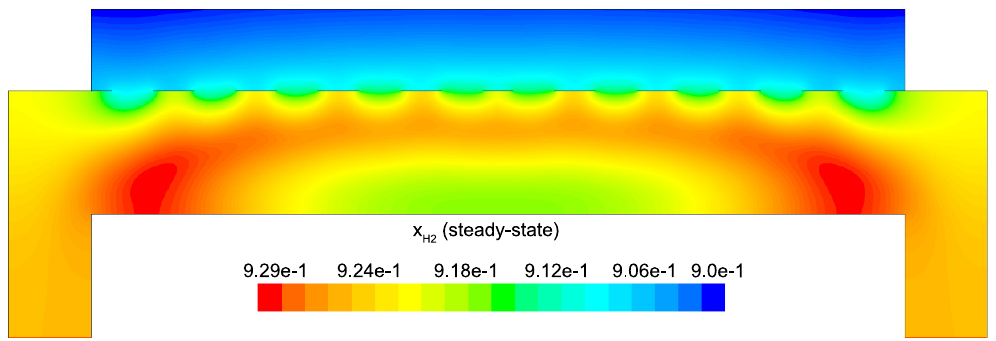
Figure 15. Steady-state profile of x H